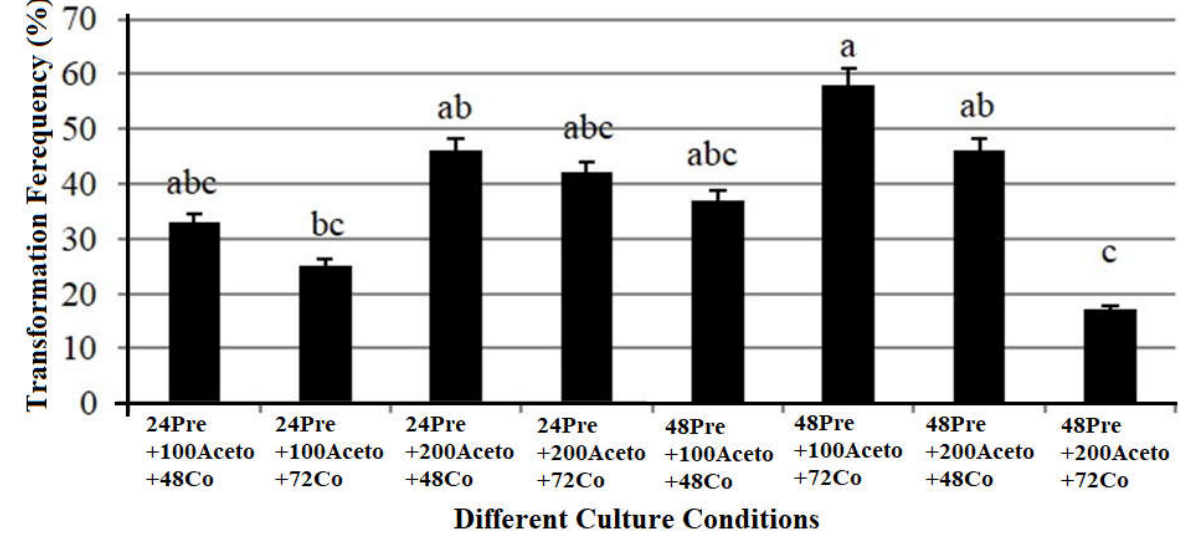
Fig. 2. Mean comparison of transformation frequency: Interaction within pre-culture time, acetosyringone concentration and co-culture time were compared.